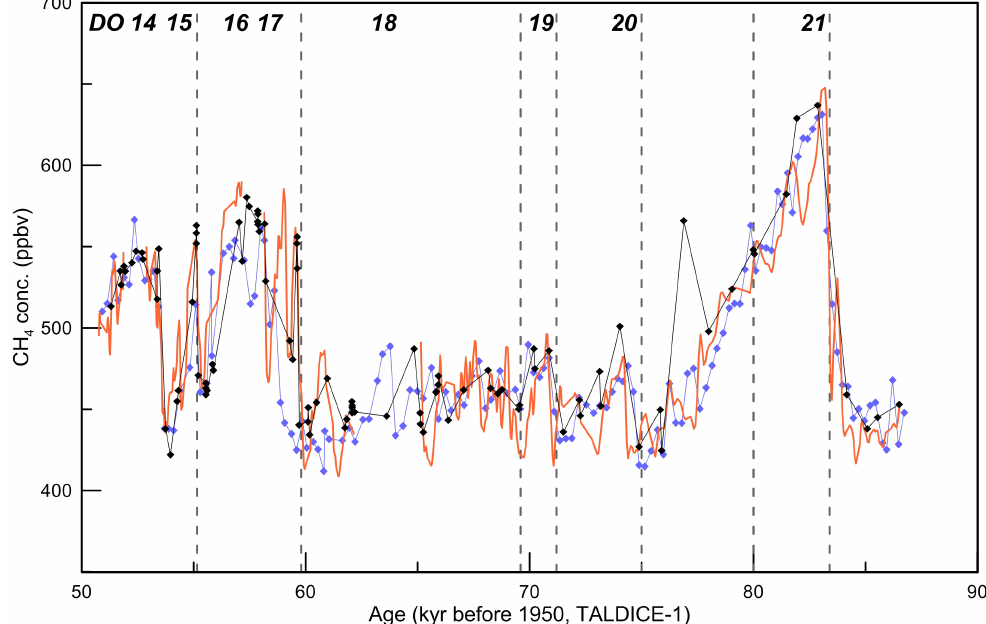
Fig. 1. The EDC CH 4 record (blue diamonds) on the EDC3 age scale is compared to the TALDICE CH 4 record (black diamonds, Buiron et al., 2011) on the TALDICE-1 age scale. The new high-resolution CH 4 record (orange line) is also shown on the TALDICE-1 age scale. Dashed lines indicate the tie points of the TALDICE-1 age scale used by Buiron et al. (2011). Bold italic numbers indicate Dansgaard- Oeschger (DO)